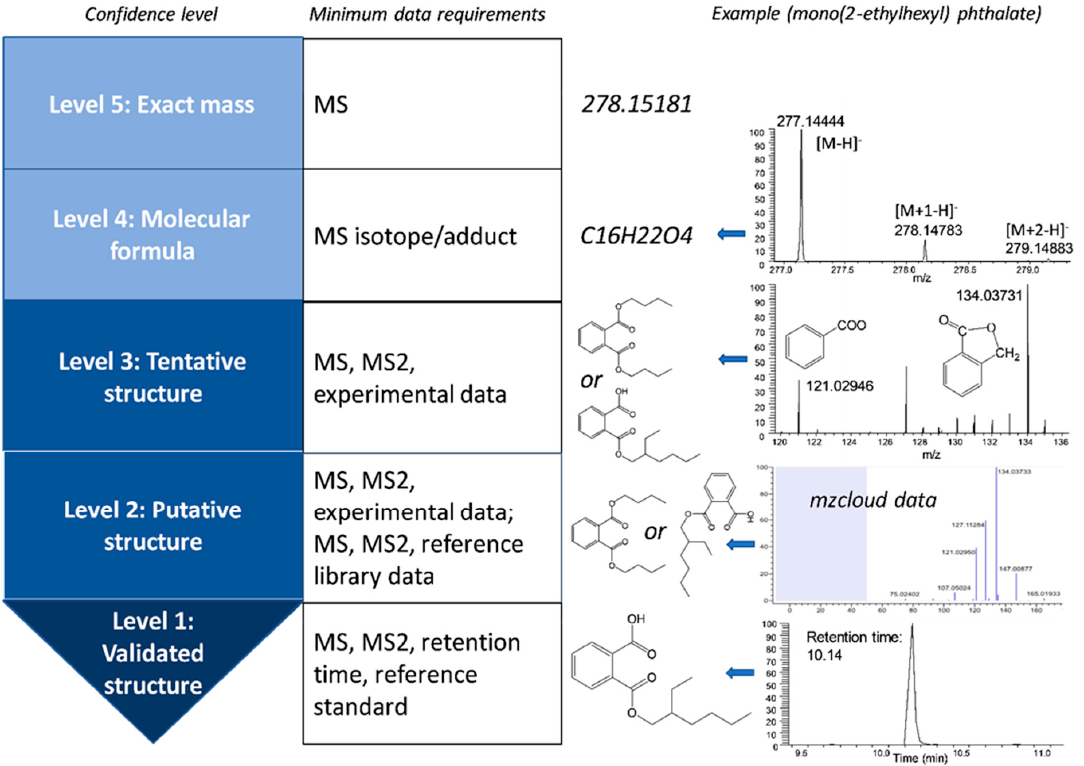
Figure 1. Proposed confidence levels in unknown xenobiotic identification with high resolution mass spectrometric analysis and exemplified with mono(2-ethylhexyl) phthalate.